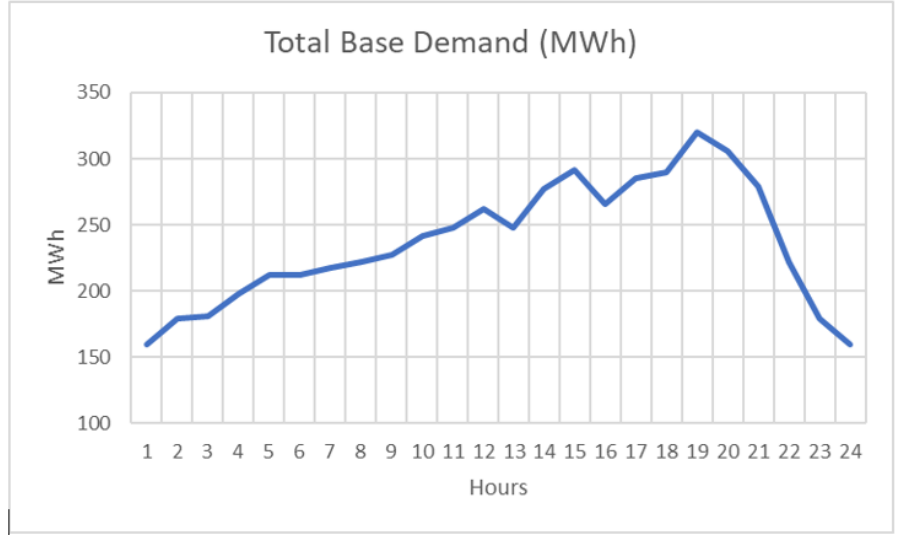
Figure 3. Total base demand of the recruited